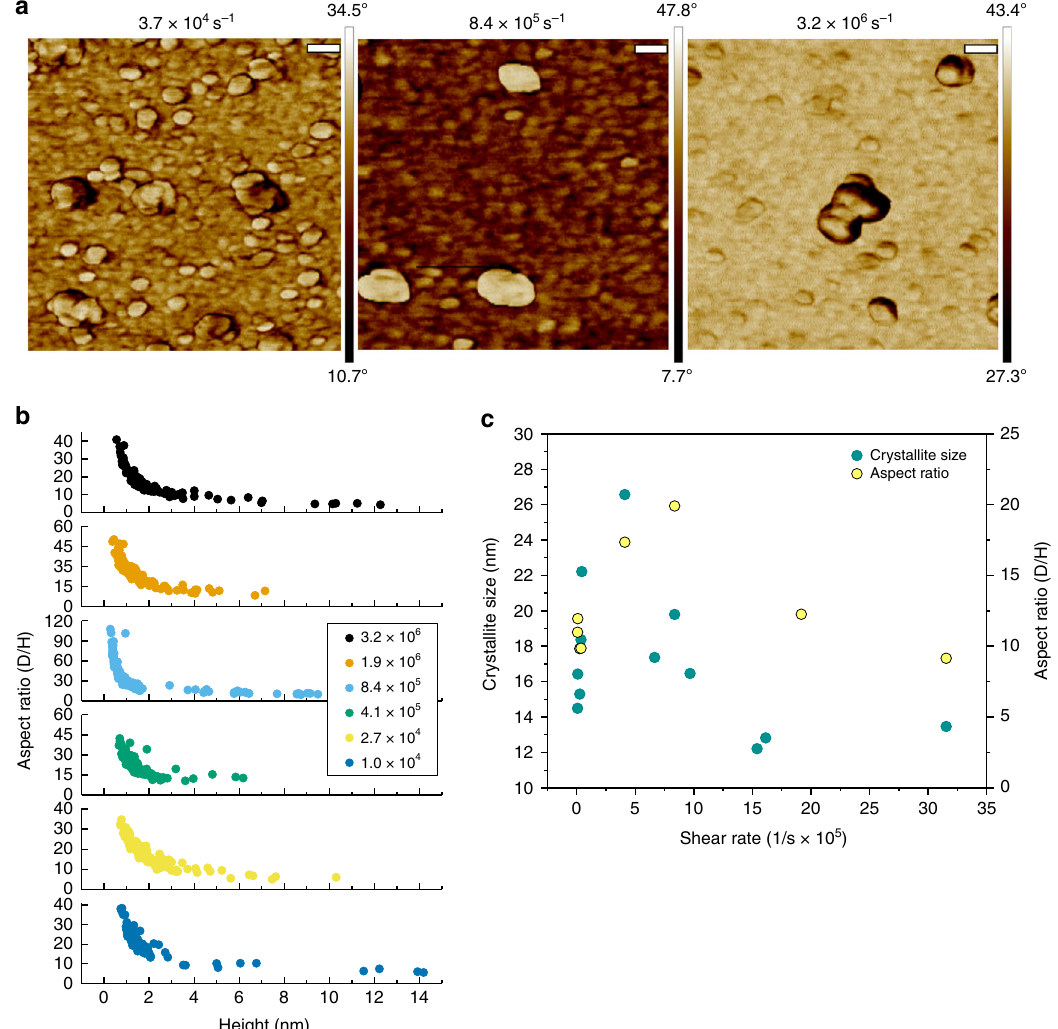
Fig. 2 LDH size, shape, and crystallinity at different shear rates. a AFM phase maps of nanoplatelets and aggregates synthesized at increasing shear rates, showing variations in shape (scale bar = 50 nm). b Trends of individual particle aspect ratios (AR) plotted against height ( H ) and shear rate. c Aspect ratio (at a thickness of 3.85 nm) and crystallite size plotted shear